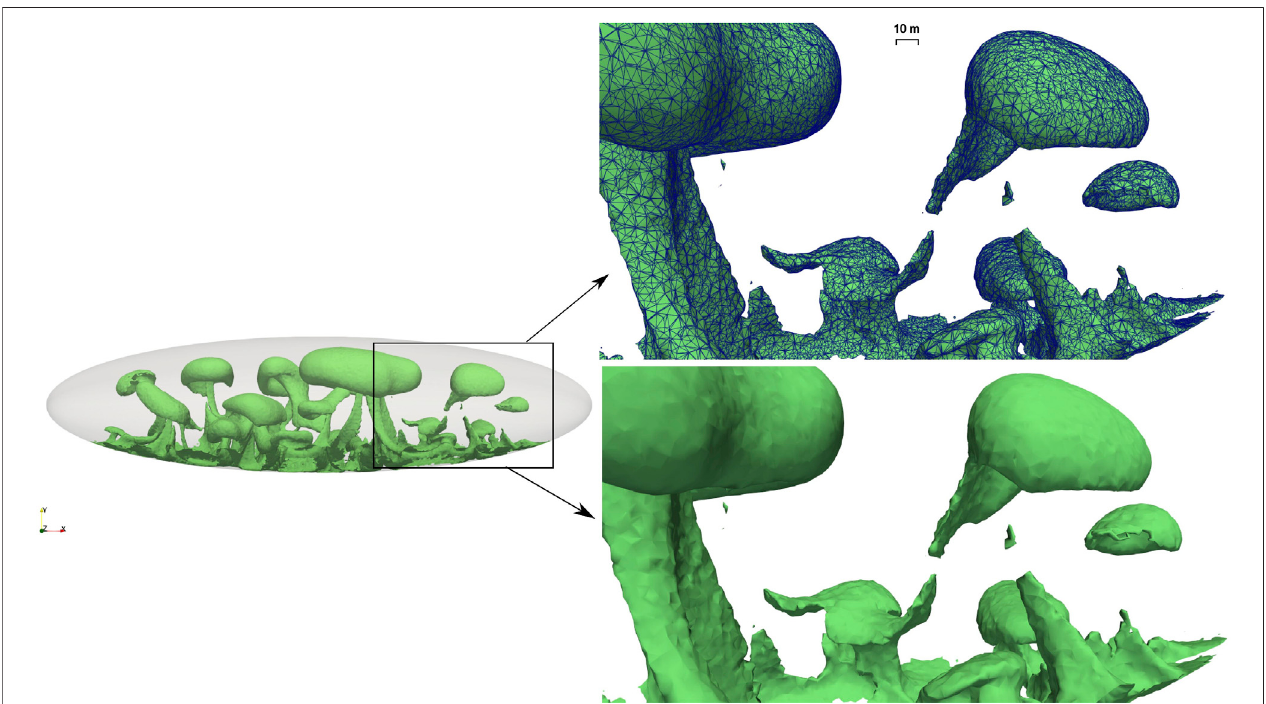
FIGURE 11 | Zoom view of the computational mesh and isosurfaces Y (cid:2) 0.5 at t (cid:2) 100 s for case